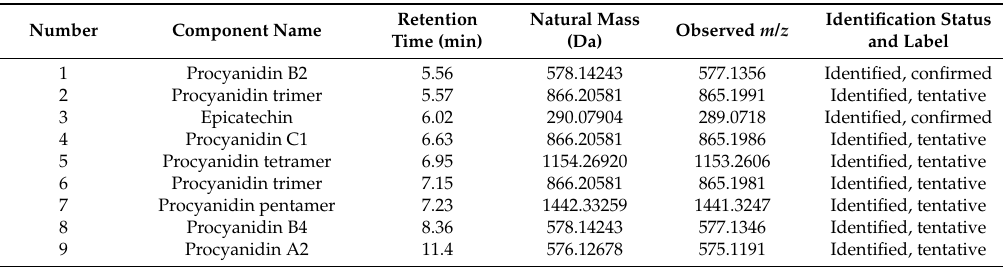
Table 7. Retention time, natural mass, observed mass-to-charge ratio ( m / z ), and identification status of the product ion of the flavonoid cocoa shell extract in negative ion